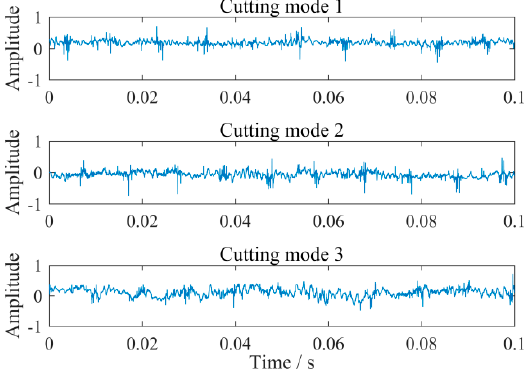
Figure 5. The waveform of the cutting sound signal.